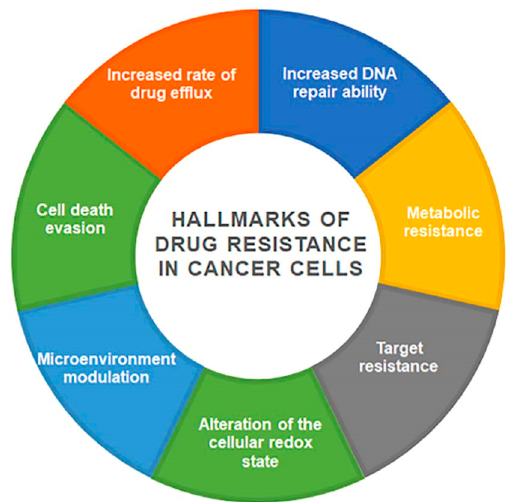
Figure 1. Schematic representation of the main mechanisms in MDR tumor. Many drugs, such as cisplatin, induce cancer cell death by binding to DNA; once DNA is damaged, cells can repair the lesions by multiple mechanisms and activate resistance mechanisms